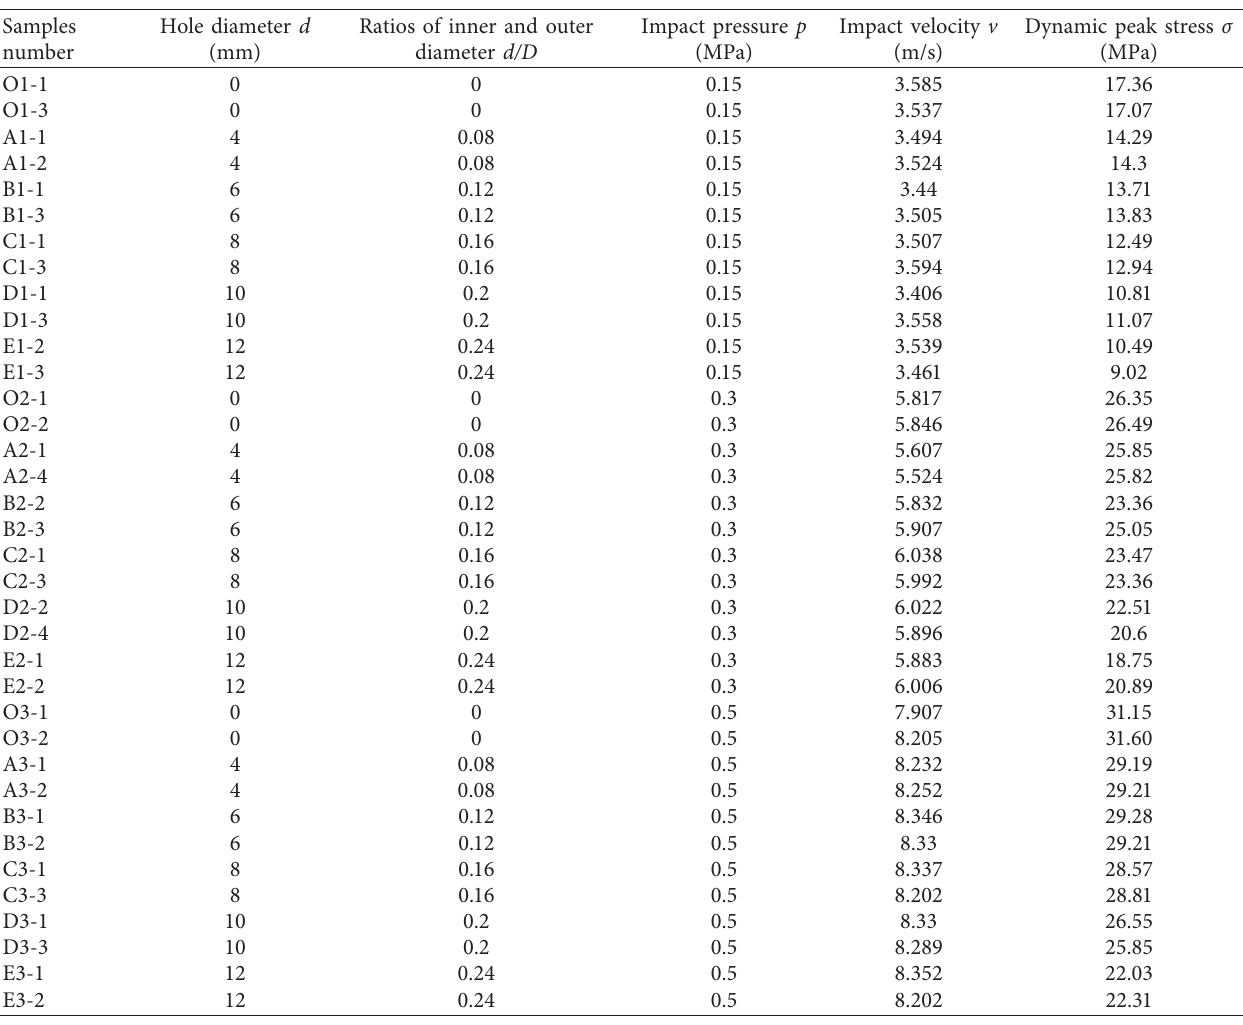
Table 2: Typical impact split test results of sandstorm specimens.